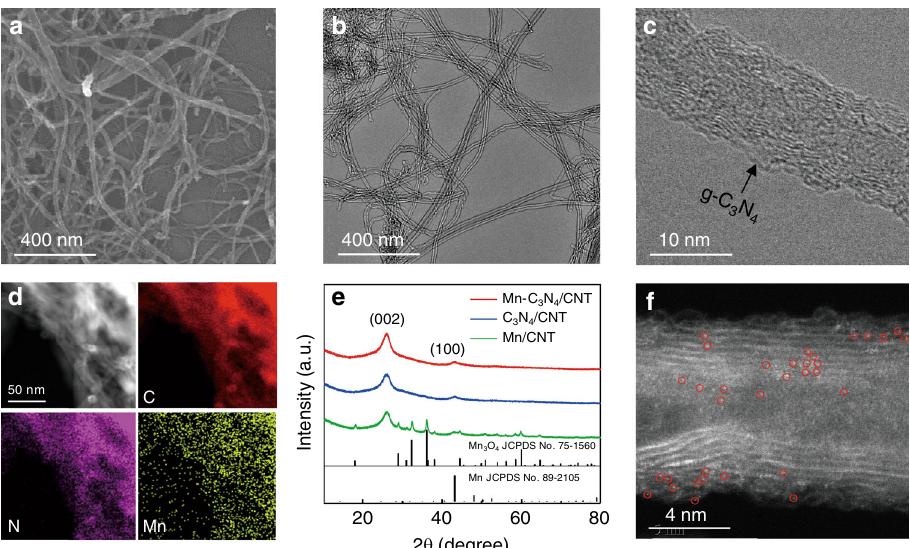
Fig. 1 Structural characterizations of Mn – C 3 N 4 /CNT. a SEM image of Mn – C 3 N 4 /CNT. b Large- fi eld view and c magni fi ed view of TEM images of Mn – C 3 N 4 /CNT. d EDS mapping of Mn – C 3 N 4 /CNT. e XRD patterns of Mn – C 3 N 4 /CNT, C 3 N 4 /CNT, and Mn/CNT. f HAADF-STEM image of Mn – C 3 N 4 / CNT with the atomic dispersion of Mn highlighted by red circles.